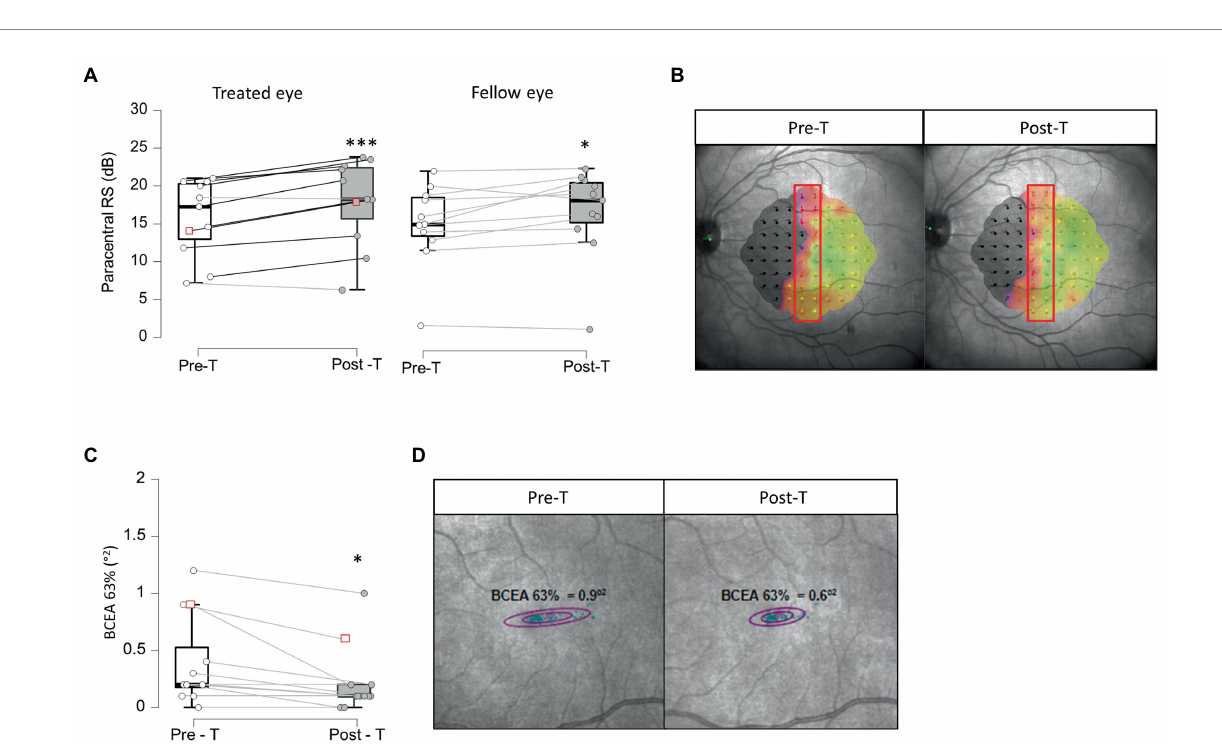
FIGURE 2 Paracentral retinal sensitivity and fixation stability. Panels (A,B) show paracentral retinal sensitivity pre-treatment (Pre-T) and post-treatment (Post-T) in treated and fellow eye in 11 patients (A) . Panel (B) represents an example of paracentral retinal sensitivity measures within red rectangle, using MAIA microperimeter before (Pre-T) and after (post-T) treatment in one patient, corresponding to red squares in (A) . *BF +0 > 3; ***BF +0 > 10 Panels (C,D) show fixation stability measured using the Best Contour Ellipse Area (BCEA) 63% pre- (Pre-T) and post-treatment (Post-T). Panel (D) represents an example of BCEA3% measured using MAIA microperimeter before (Pre-T) and after (post-T) treatment in one patient, corresponding to red squares in (C) . *BF -0 >